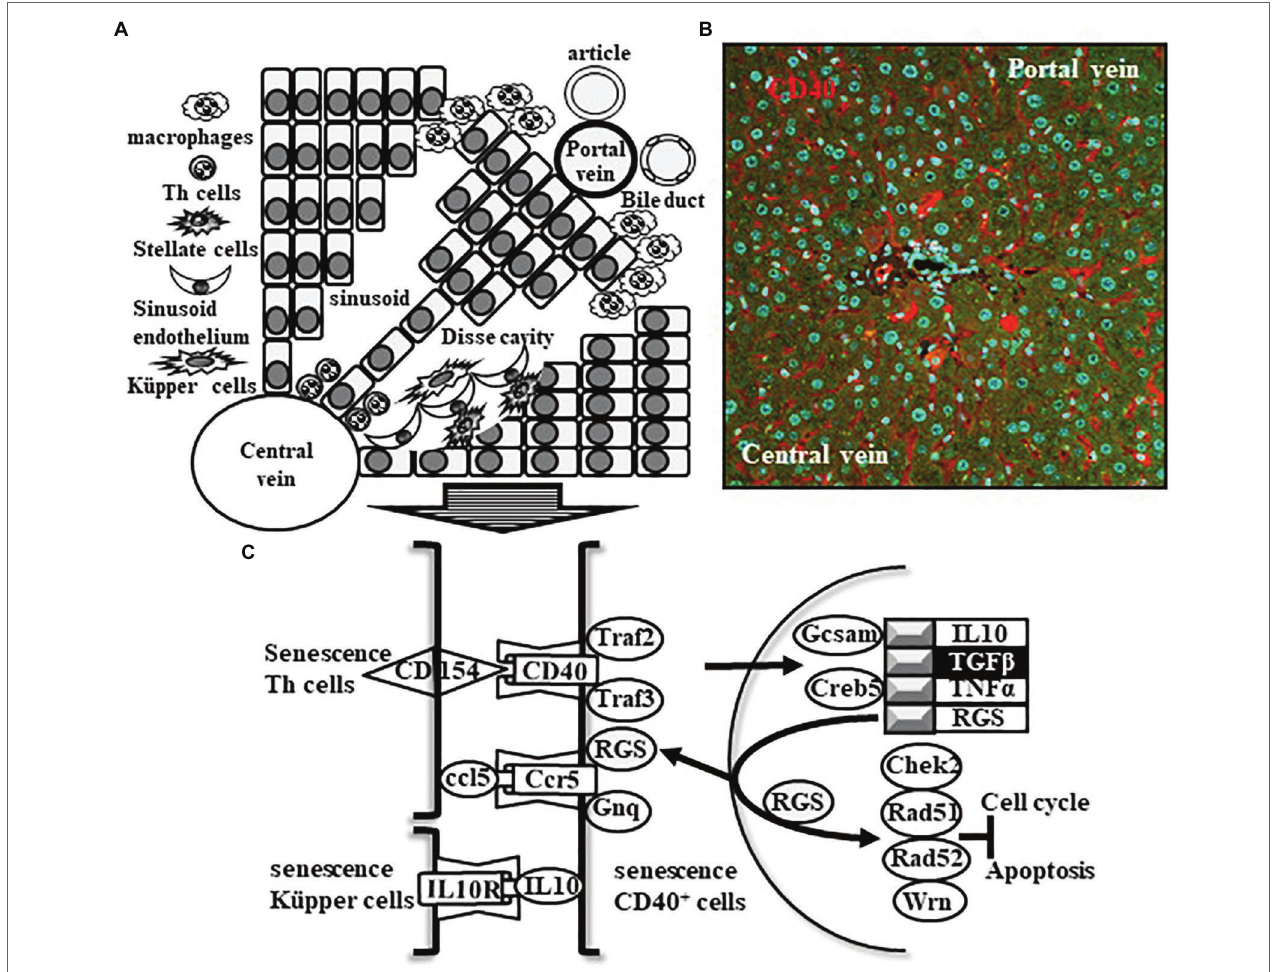
FIGURE 4 | Schematic image of inflammation and fibrosis in old nonalcoholic steatohepatitis (NASH) patients. Cell–cell interactions between stellate cells, senescent sinusoid endothelium, and senescent Küpper cells at the Disse cavity of the liver sinusoid of elderly NASH patients induce the activation of HSCs for inflammation and fibrosis. (A) This mechanism is a main pathway. (B,C) Conversely, infiltrating senescent Th cells into the liver sinusoid interacts with senescent CD40 + cells during SASP-induced chronic inflammation in a disease-specific microenvironment, and downstream signal-dependent production of TGF β participates in an alternative fibrosis